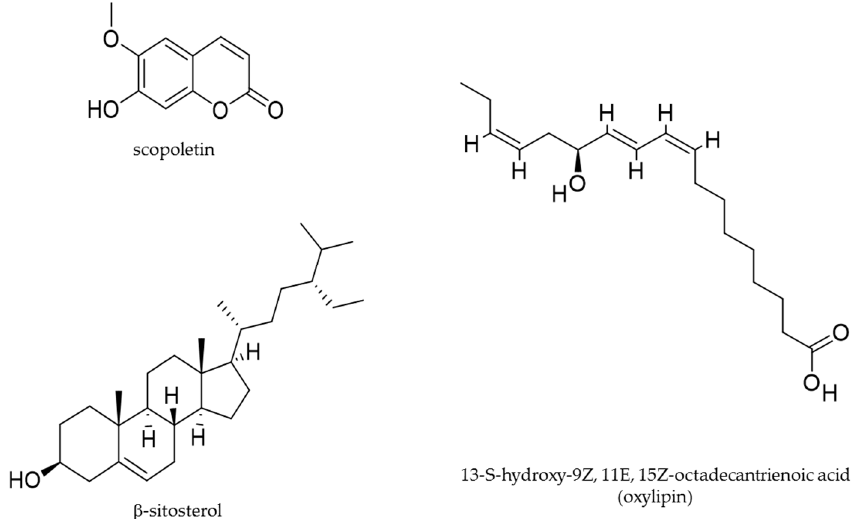
Figure 3. Molecular structures of selected bioactive phytochemicals isolated from U. dioica . Table 3. Biological activities of specific molecules isolated from U. dioica .